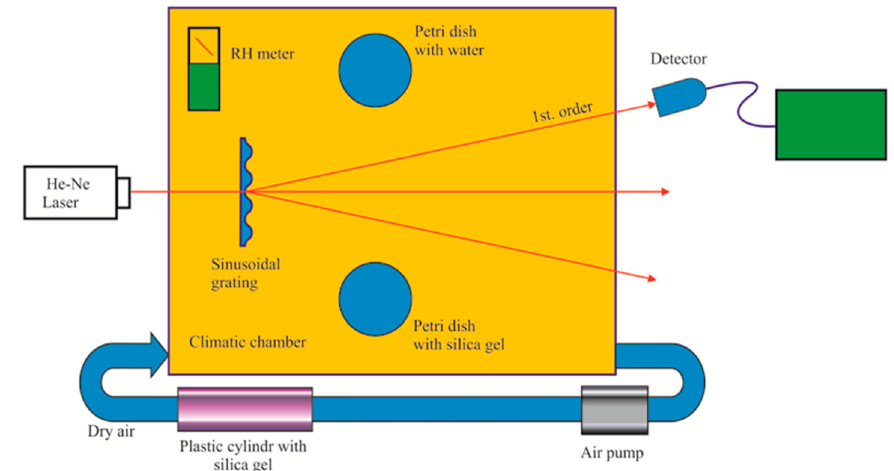
Figure 17. Schematic of a climatic chamber. Electronic RH instrument was used for calibration purposes. One Petri dish contained water and the other silica gel. Both dishes had lids that can be moved from outside.